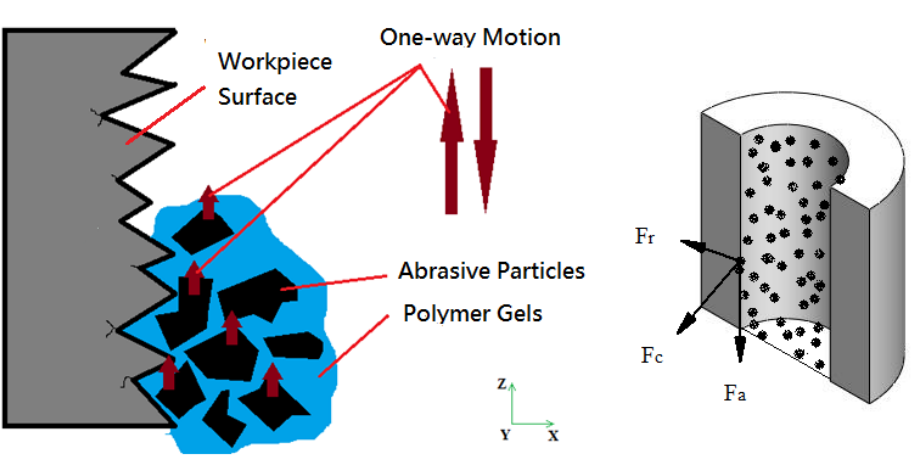
Figure 3. Diagram of the force components in traditional AFM.